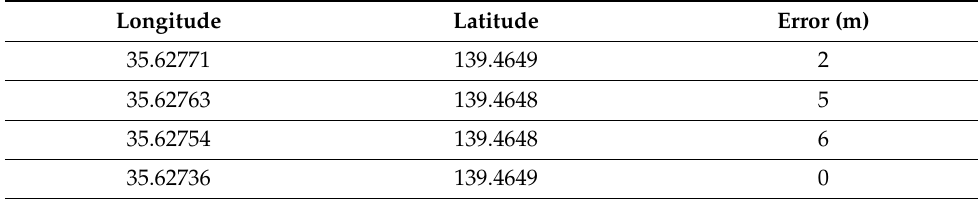
Table 2. Latitude/longitude and error distance in Figure